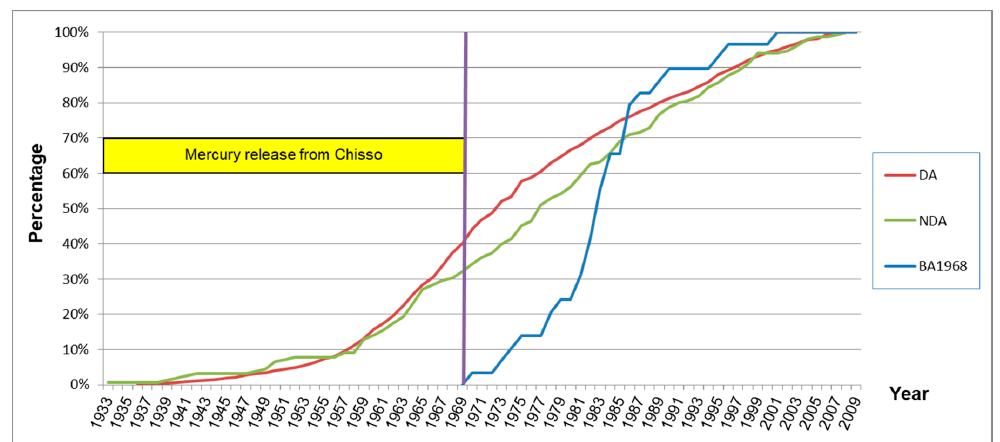
Figure 14. Onset year of the first symptom of subjects with and without residential history in the designated area (percentage).